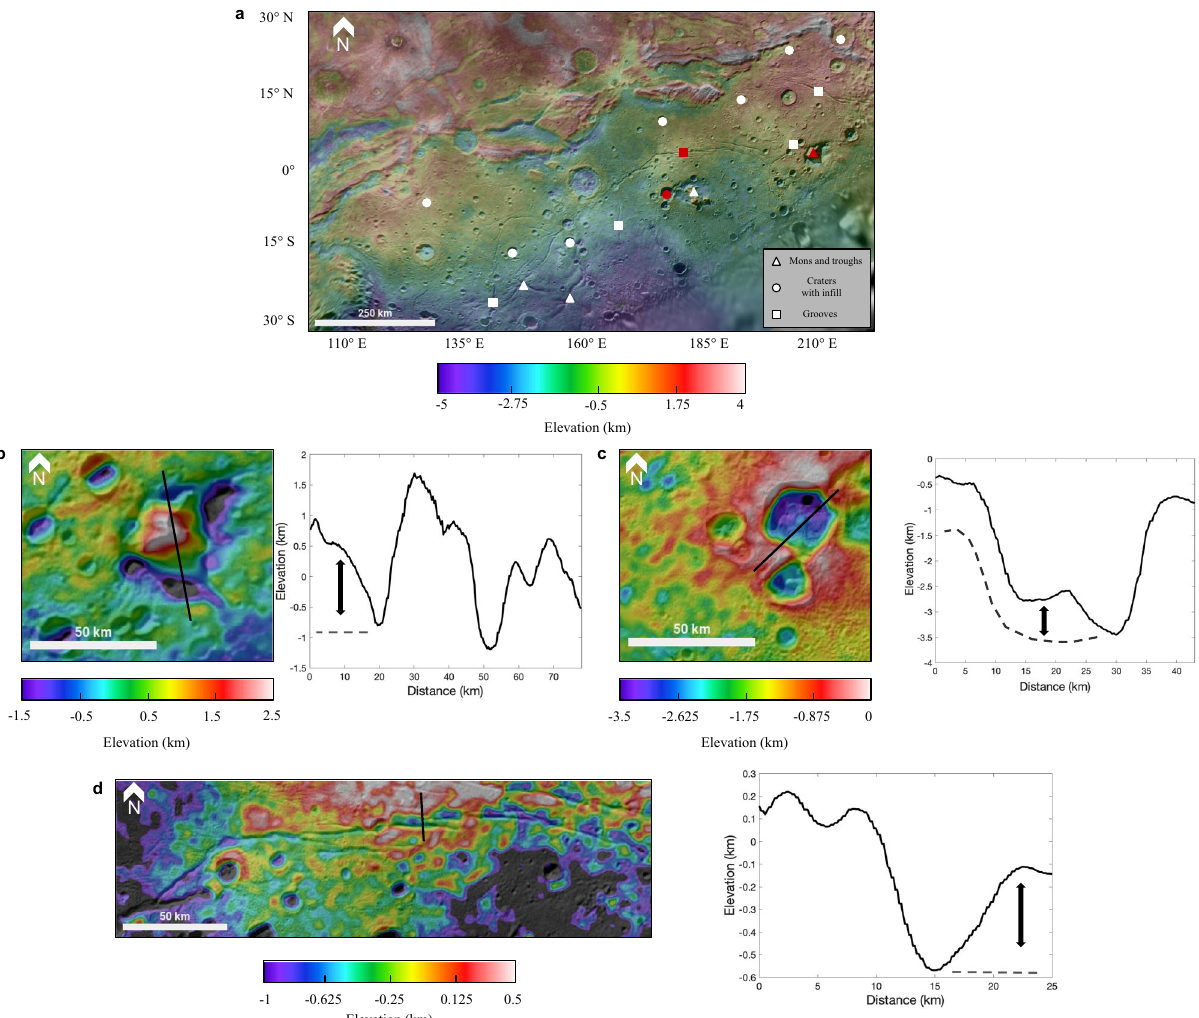
Fig. 2 Observations of geologic features within Vulcan Planitia. a Locations of all geologic features that yielded Vulcan Planitia thickness constraints. Circles denote craters with in fi ll, triangles mons and troughs, and squares tectonic grooves. b Kubrick Mons surrounded by a low-lying trough (red triangle in a ) with corresponding topographic pro fi le demonstrating measurements of the surrounding Vulcan Planitia cryo fl ow. c A crater with evidence of possible in fi ll (red circle in a ), and an example demonstrating the identi fi cation of thickness of the cryo fl ow. d The largest tectonic groove found within Vulcan Planitia (red square in a ). Measurements of tectonic groove depth were taken on the side with the lowest elevation to ensure a minimum thickness constraint. All image and topography data used to generate this fi gure is publicly available in the NASA Planetary Data System Small Bodies node (https://